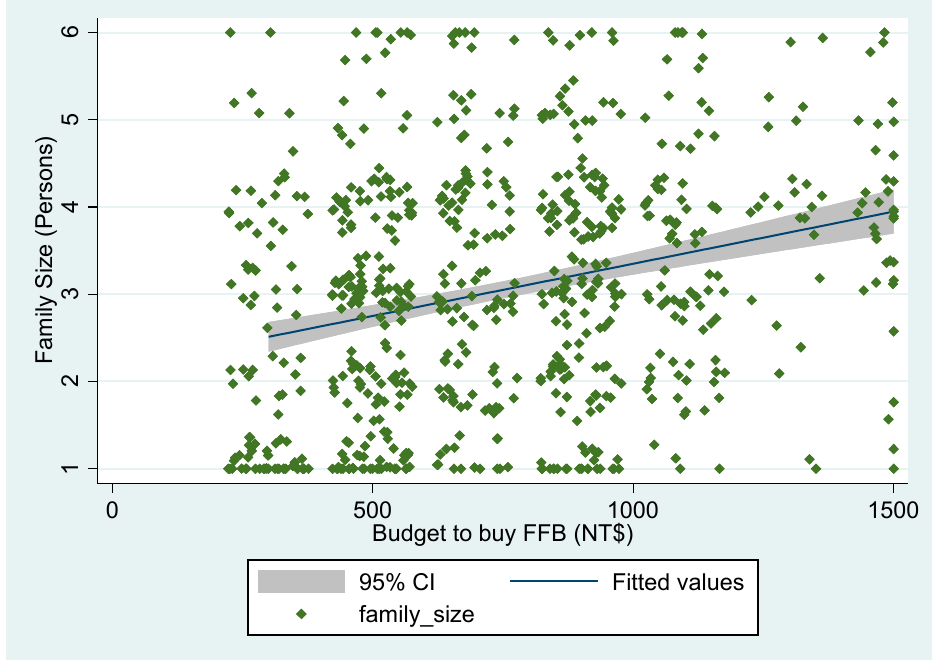
Figure 2. The relationship between family size and fresh food box budget. Note: FFB means a fresh food box